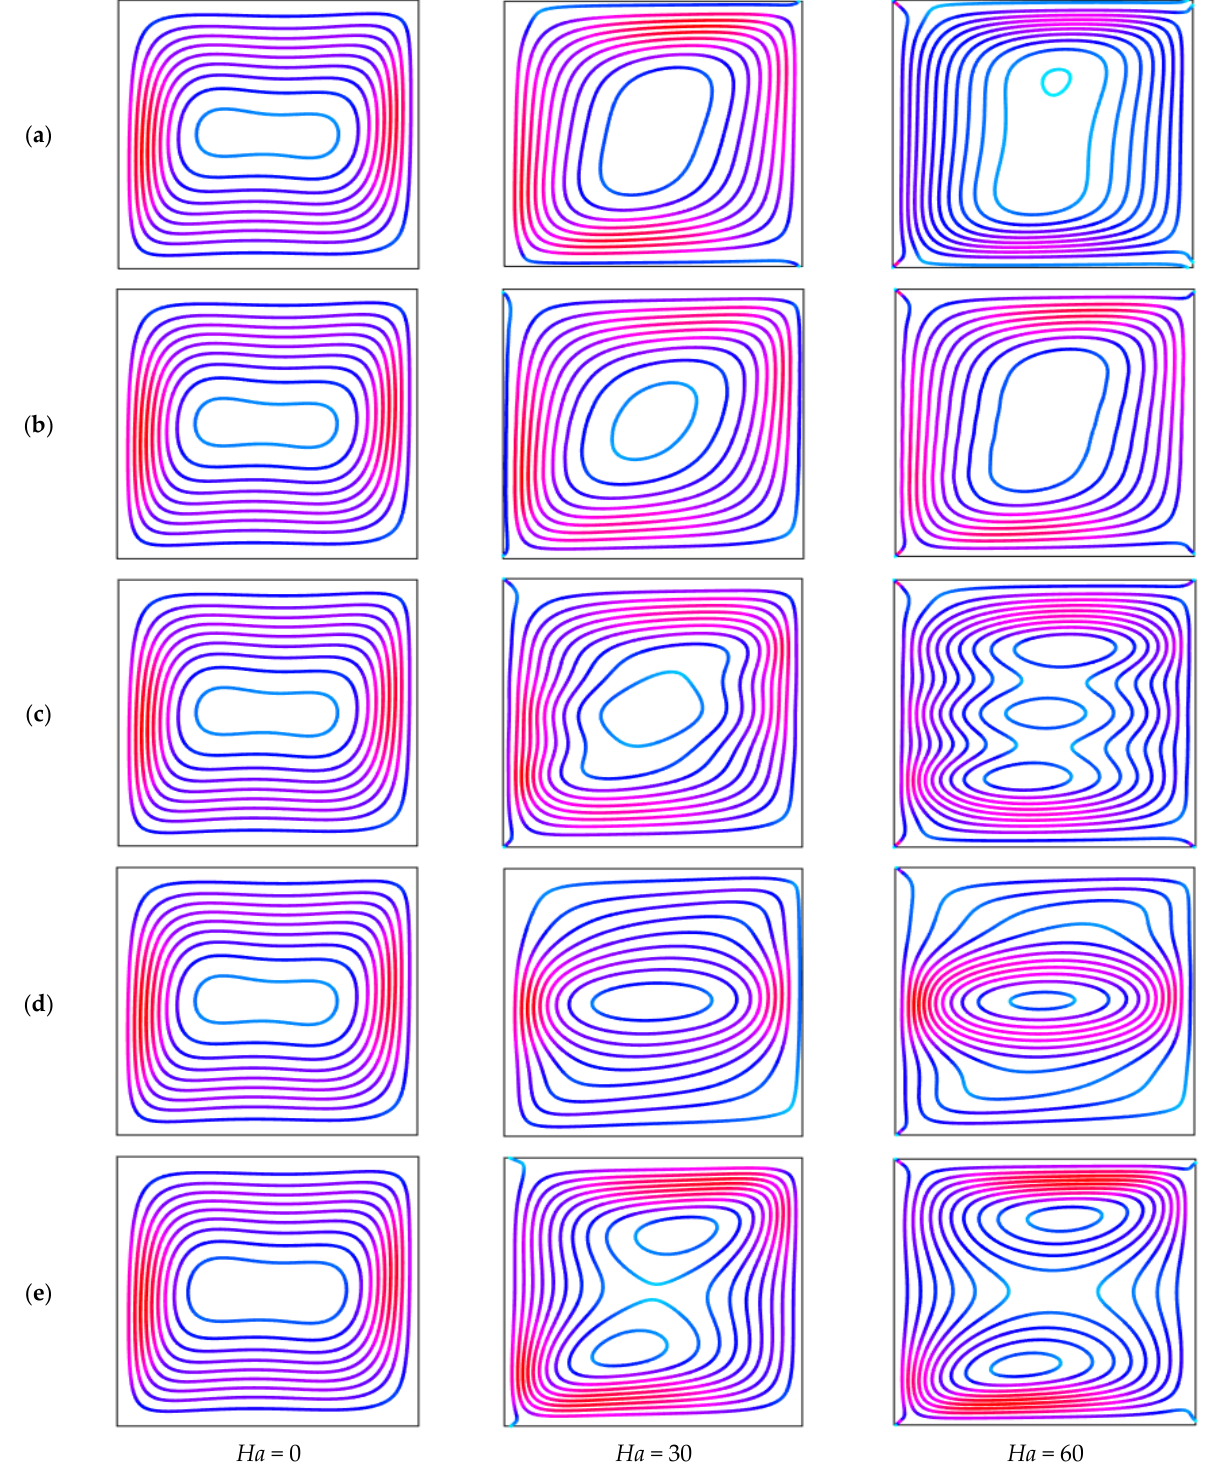
Figure 3. Effect of streamline contours for various Hartmann number ( Ha ) for ( a ) uniform magnetic field (umf), ( b ) λ = 0.1, ( c ) λ = 0.25, ( d ) λ = 0.5, and ( e ) λ = 1 when Ra = 10 6 , d = 10 nm, ϕ = 0.04, n = 3, Pr = 6.8377, and τ = 1.